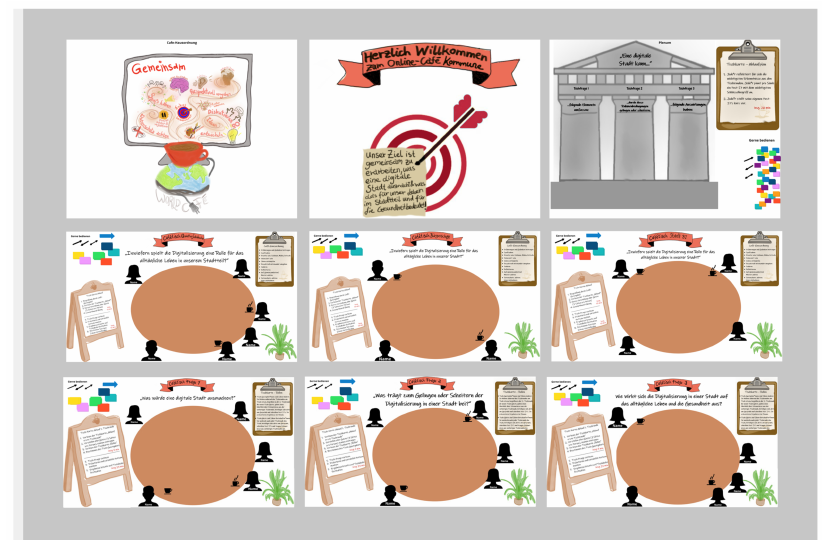
Figure A1. Empty digital pinboard before the online World Caf é